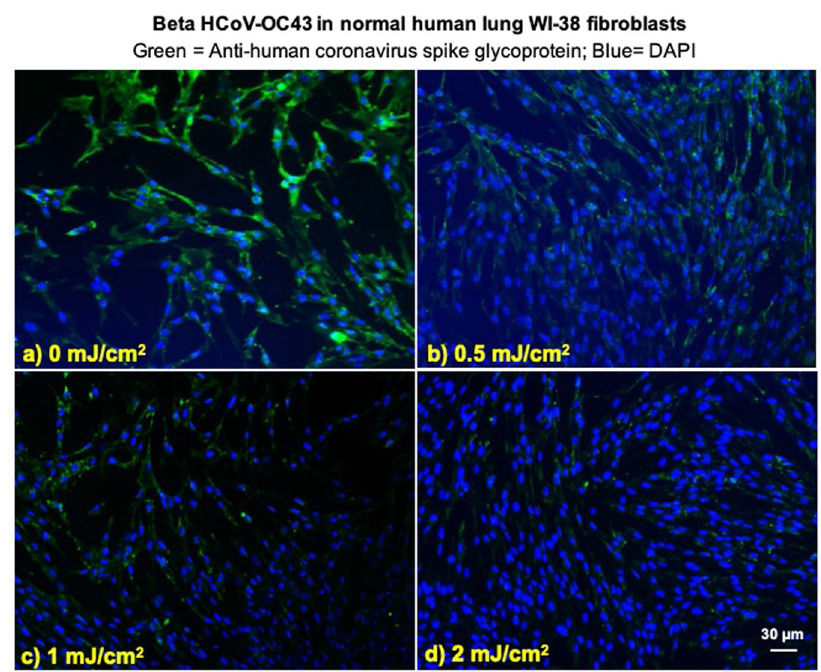
Figure 3. Infection of human lung cells from irradiated aerosolized beta HCoV-OC43 as function of dose of far-UVC light. Representative fluorescent images of WI-38 normal human lung fibroblasts infected with human betacoronavirus OC43 exposed in aerosolized form. The viral solution was collected from the BioSampler after running through the aerosol chamber while being exposed to ( a ) 0, ( b ) 0.5, ( c ) 1 or ( d ) 2 mJ/cm 2 of 222-nm light. Green fluorescence qualitatively indicates infected cells (Green = Alexa Fluor-488 used as secondary antibody against anti-human coronavirus spike glycoprotein antibody; Blue = nuclear stain DAPI). Images were acquired with a 10× objective; the scale bar applies to all the panels in the figure.